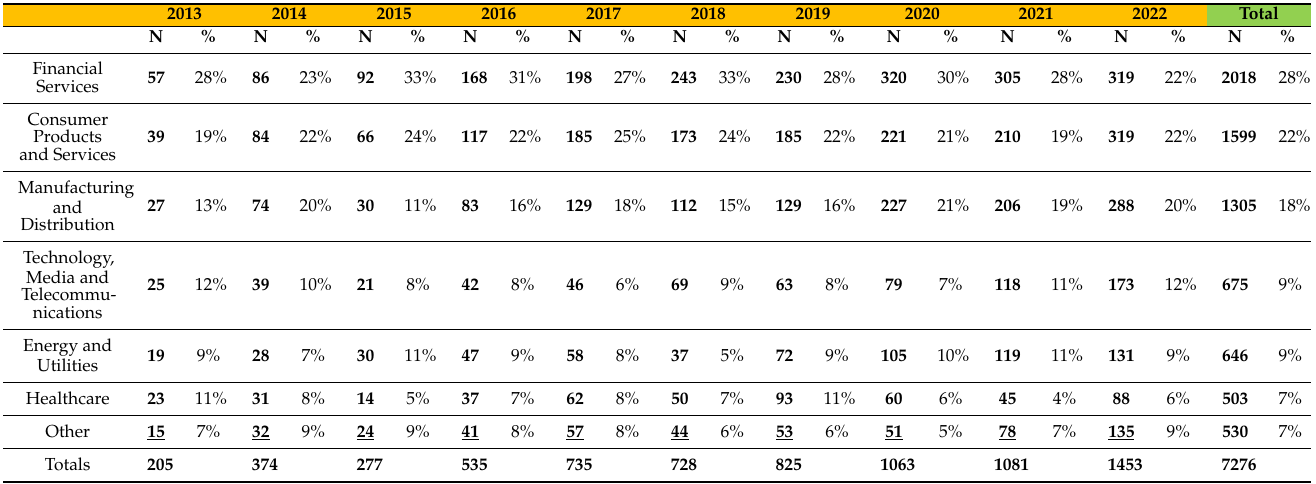
Table 2. Sample Responses by